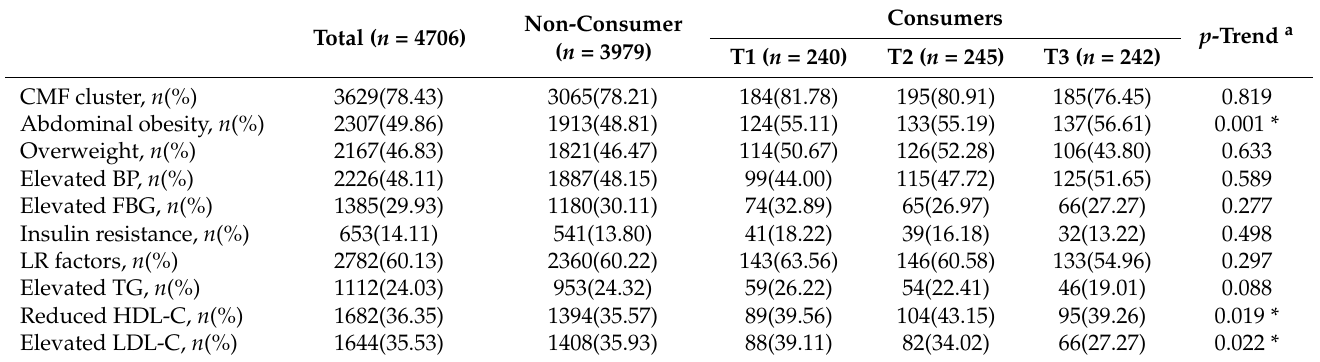
Table 2. Prevalence of CMFs in 2015 among Chinese adults across the baseline levels of whole grain